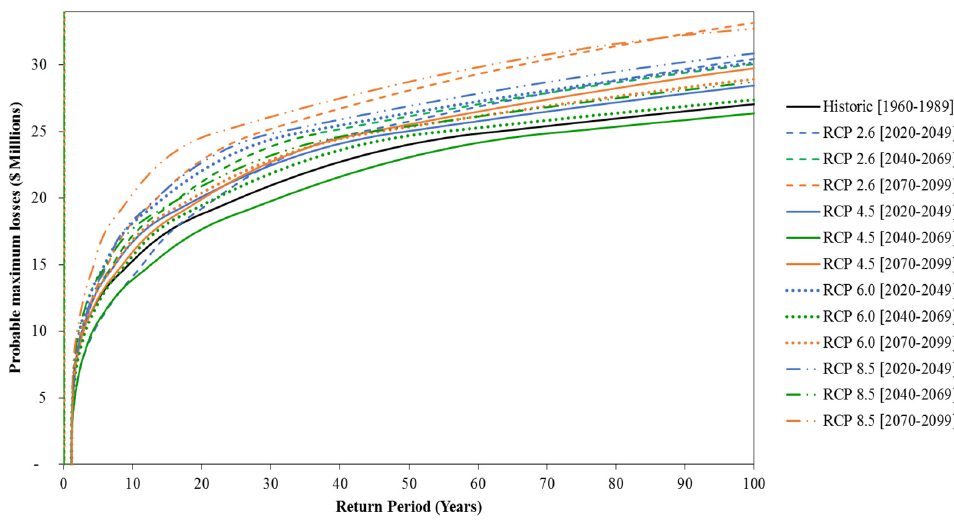
Figure 17. Probable maximum loss curves.